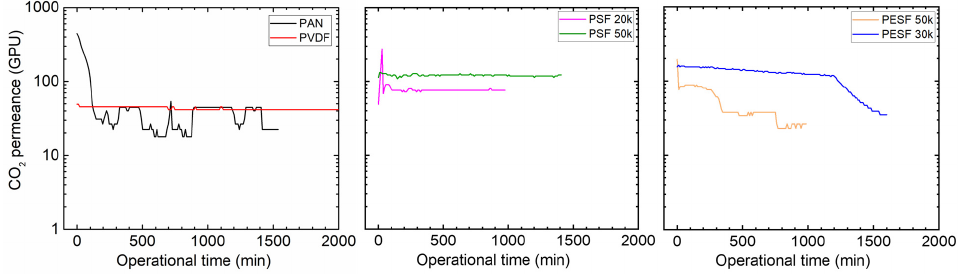
Figure 11. Gas permeation of Pebax TFC membranes coated on various supports with a feed pressure of 2 bar at 35 °C, 100%RH. As can be seen from Figure 11, except for the membranes cast on the supports of PVDF and PSF 50k, those of the other four supports experienced a reduction in CO 2 per- meance over time. The membrane cast on the PAN support started with a rather high CO 2